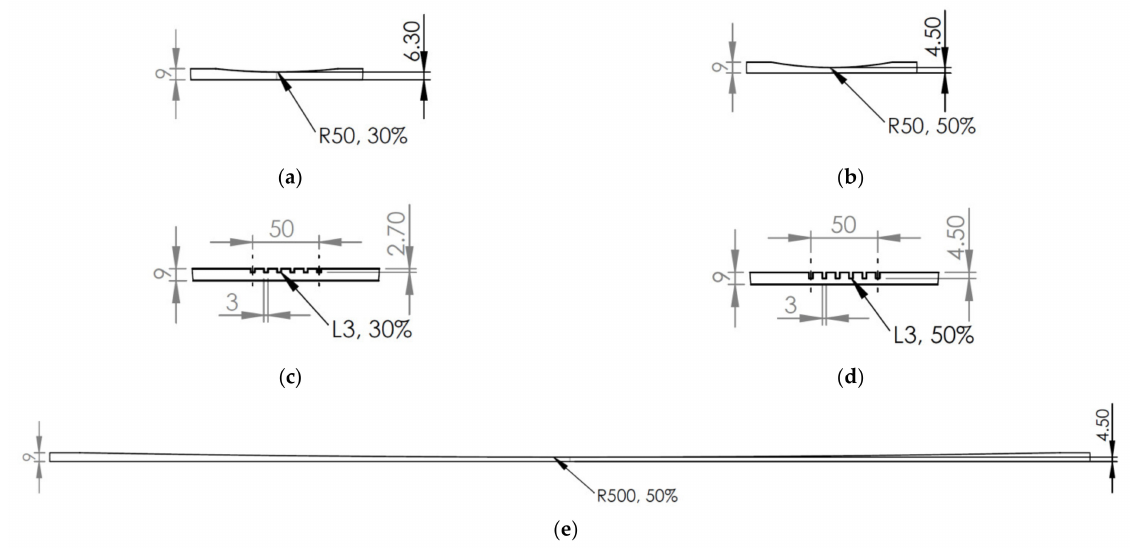
Figure 19. Defect geometries considered in virtual experiment: ( a , b ) localized defect with 30% and 50% wall thickness loss, ( c , d ) pitting defect with 30% and 50% of wall thickness loss, and ( e ) smooth wall thickness loss at 1000 mm zone with maximum depth of 50% of the wall